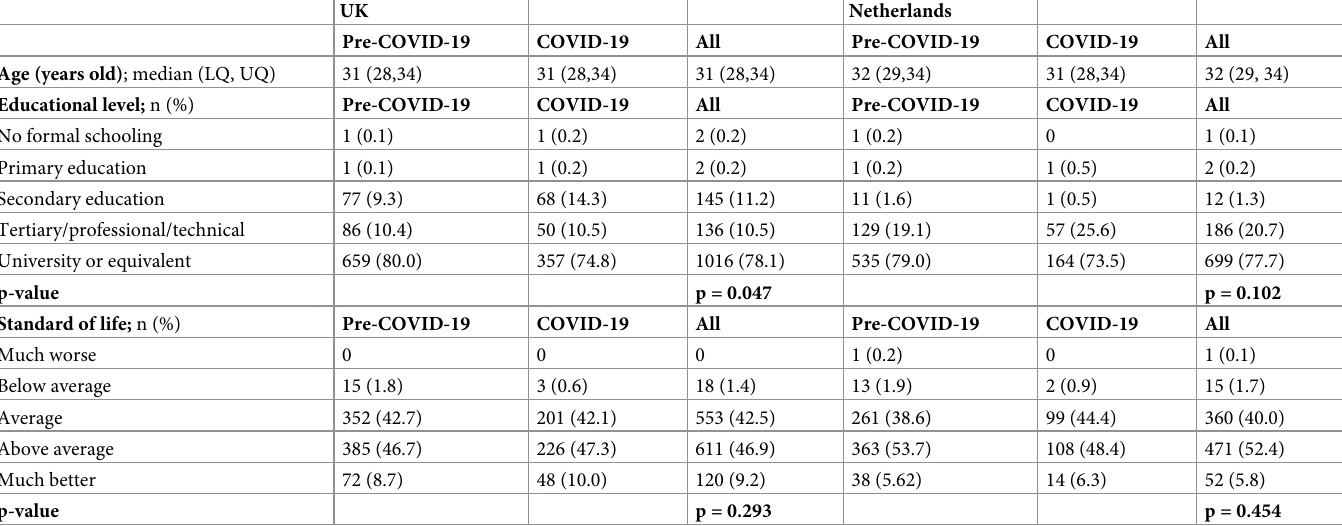
Table 2. Demographics of participants who completed the